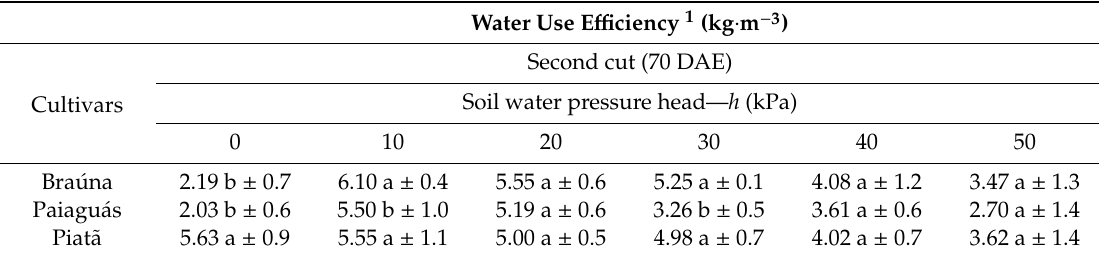
Table 6. E ff ect of soil water pressure head on water use e ffi ciency ( Brachiaria brizantha cultivars) for the second cutting